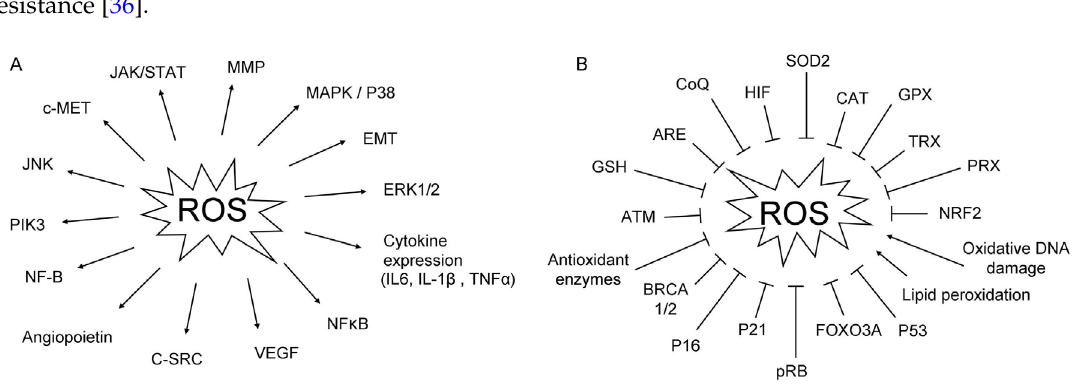
Figure 1. Molecular factors and pathways involved in reactive oxygen species (ROS) regulation. ( A ) Different genes, and pathways activated by ROS; ( B ) different genes, enzymes, and biochemical reactions that inhibit or promote ROS production. Arrows indicate activation and bar-headed arrows refer to inhibition.